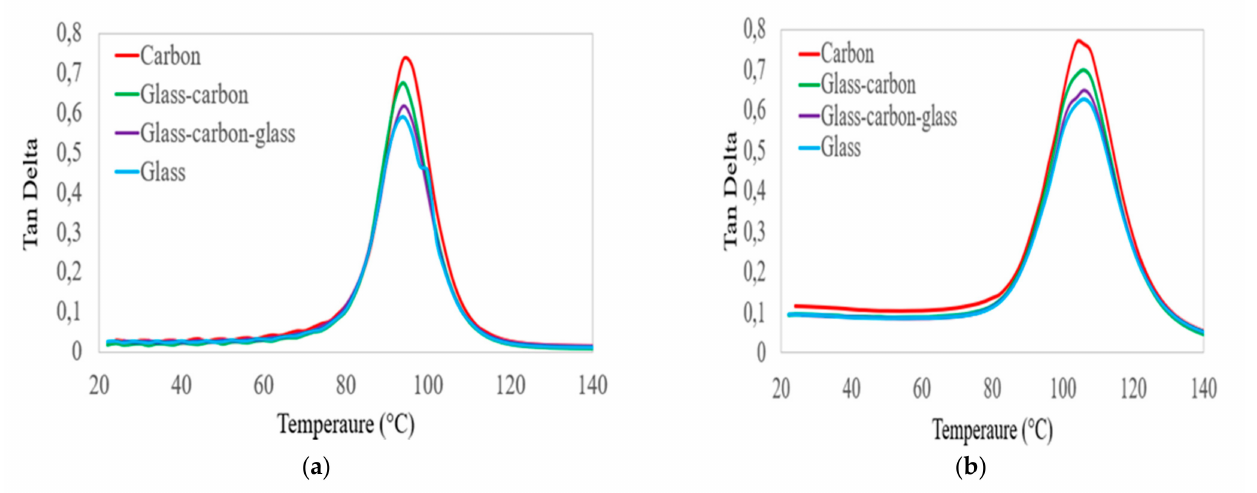
Figure 7. Comparison of the values of damping factor on hybrid and non-hybrid bidirectional laminates at frequencies of ( a ) 1 Hz and ( b )100